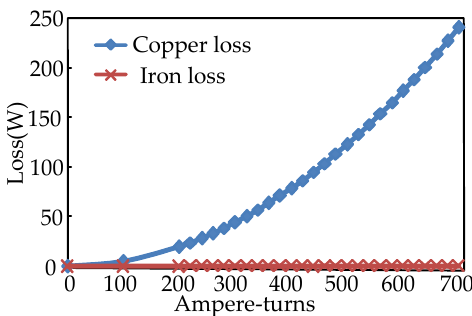
Figure 7. Variation of losses with ampere-turns.